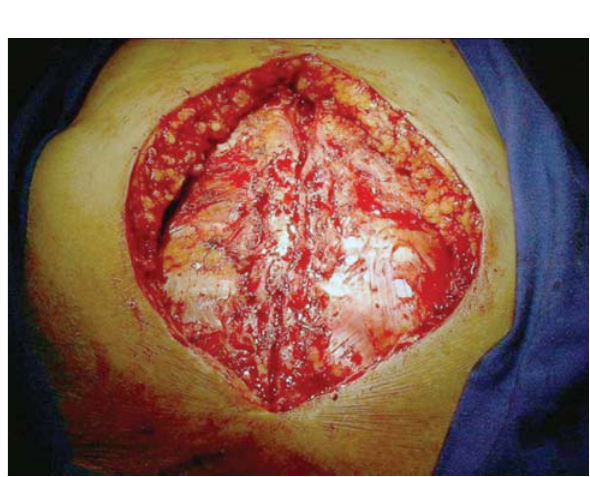
Fig. 2 - Defeito na parede torácica